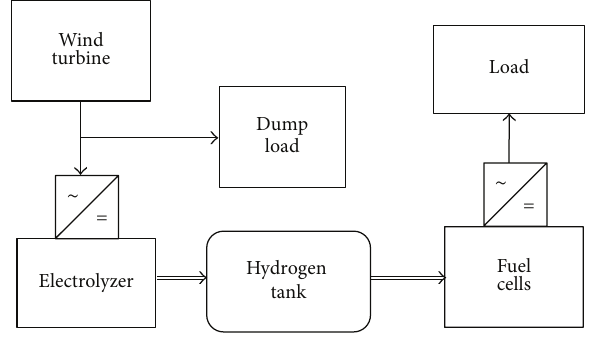
Figure 2: Wind/hydrogen system.